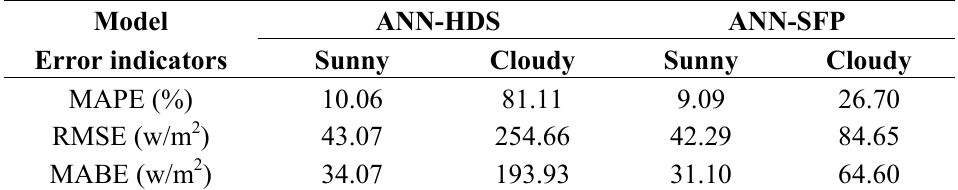
Table 1. Error statistical indicators of the forecast